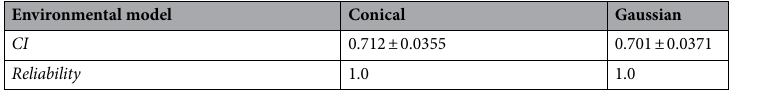
Table 2. Chemotaxis performance of the random-walk model elegans in two environmental models ( n = 100, ± s.d.).